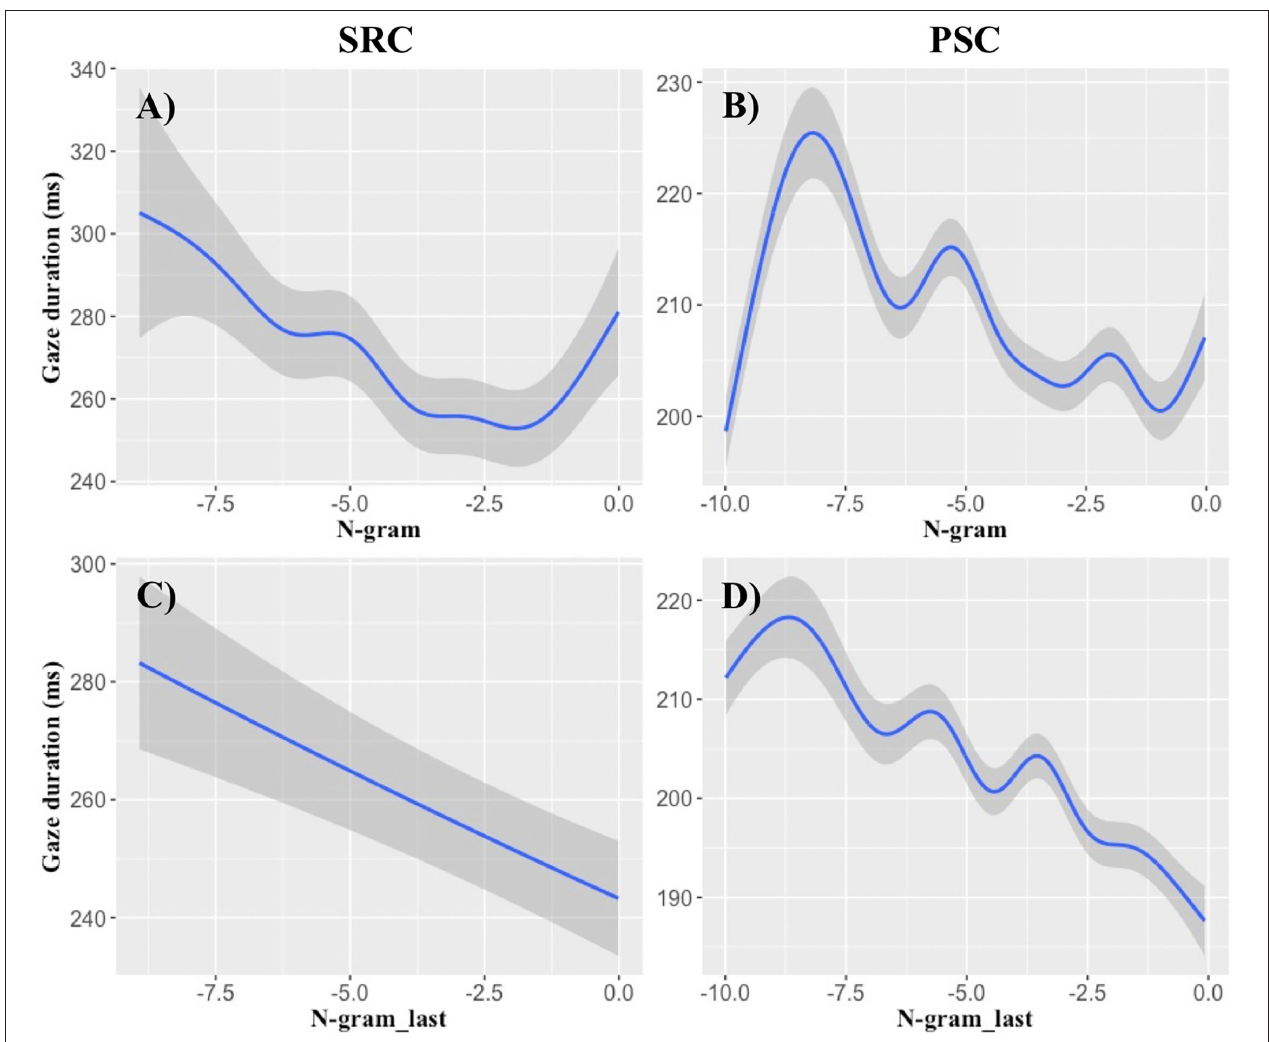
FIGURE 2 | N-gram probability effects on gaze durations. The x-axes display log-transformed n-gram probability, while the y-axes demonstrate its influence on gaze durations (ms) of the full GAM models (cf. Table 8 ). (A,B) Demonstrate the effects of the present-word n-gram probabilities, while (C,D) Illustrate the influence of the n-gram probability of the last word on the gaze durations of the currently fixated word. Results of the SRC data set are given in (A,C) , while PSC data are illustrated in (B,D) . Large log-transformed n-gram probabilities lead to an approximately linear decrease of gaze durations, particularly in a log-range of − 8 to − 1. Shaded areas indicate standard